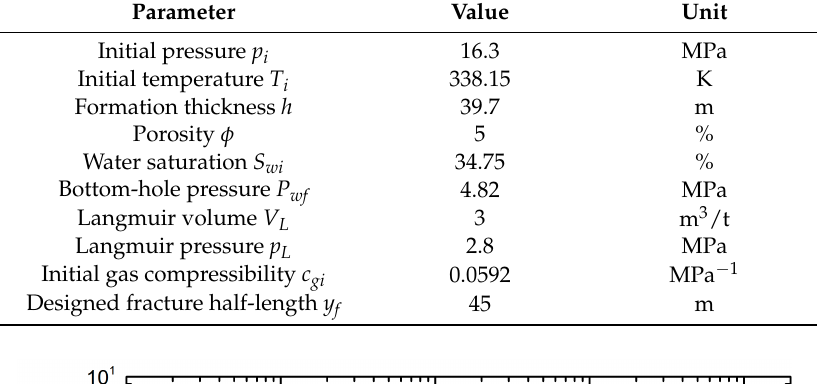
Table 2. Reservoir and fracture data.